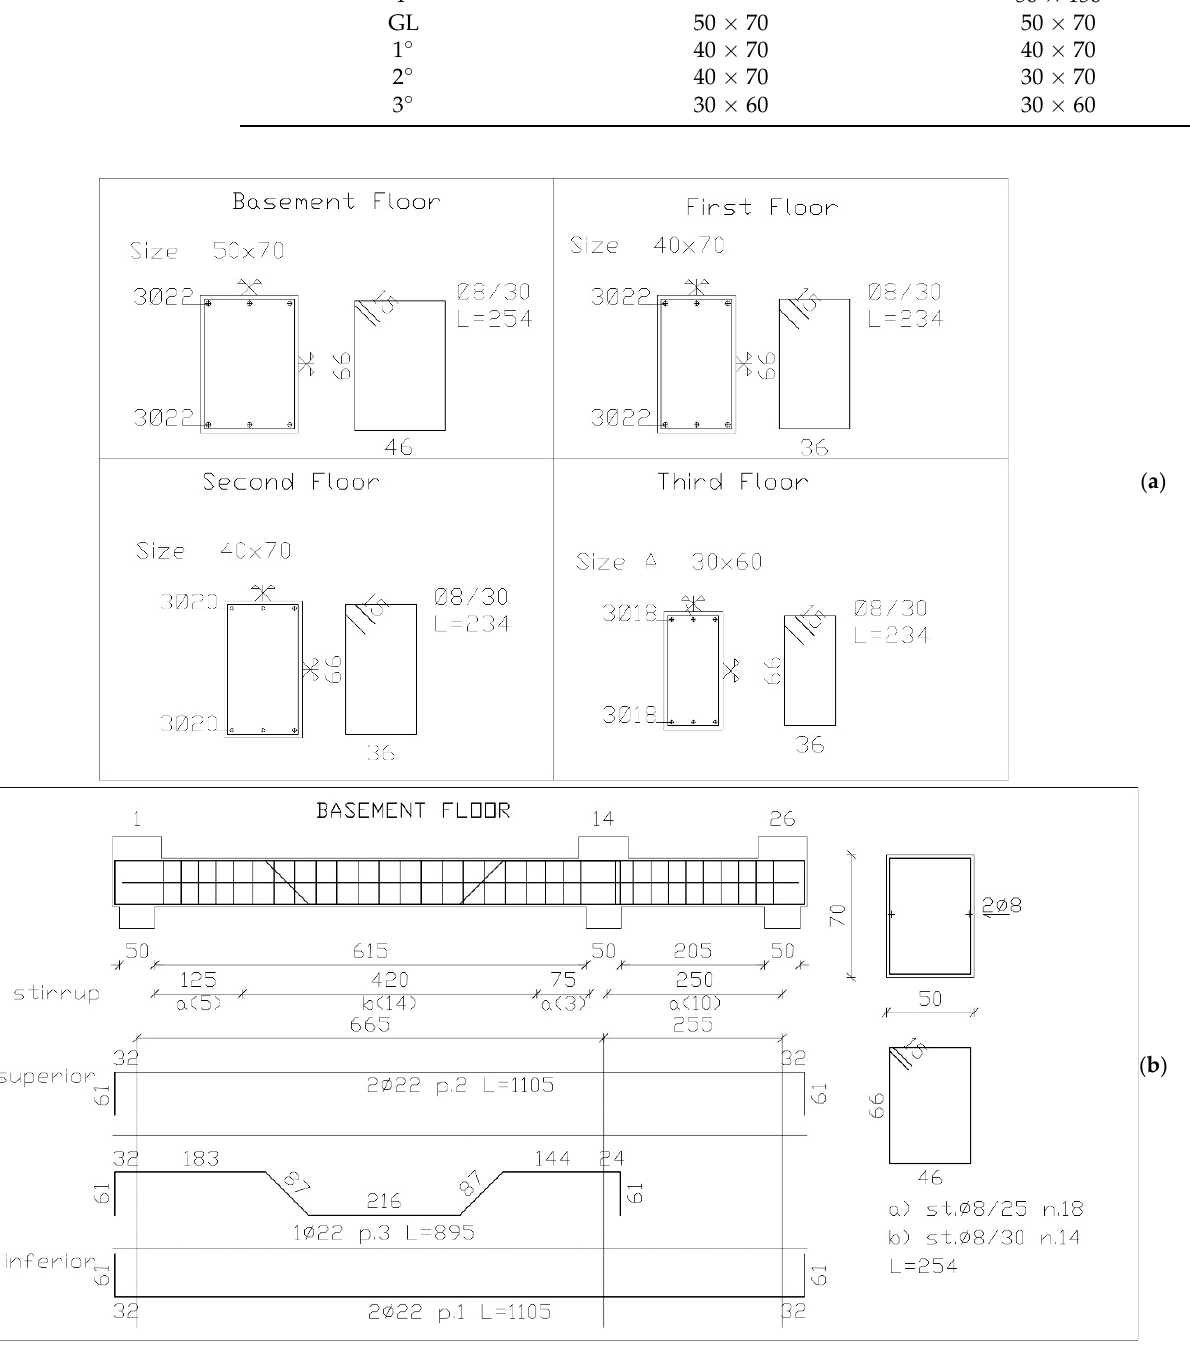
Figure 6. Examples of geometric details for ( a ) columns and ( b ) beams for the Frangipane School (scanned technical drawings), with dimensions in cm).